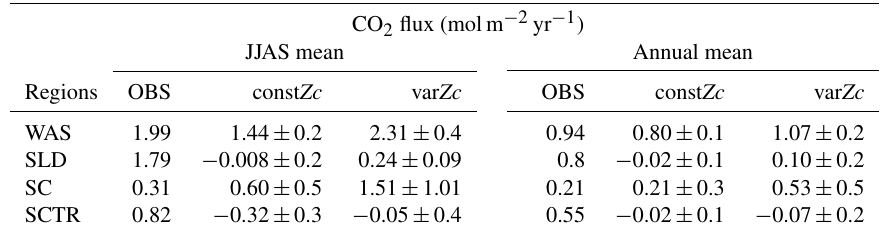
Figure 8. Annual mean bias of model phosphate when compared with climatological observational data (a) for const Zc and (b) for var Zc simulations. Corresponding annual mean biological source–sink profiles (c, d) in the model for WAS. Unit of phosphate is mmolm − 3 and biological source–sink is gCm − 3 yr − 1 . Table 1. WAS is western Arabian Sea, SLD is Sri Lanka Dome, SC is Sumatra coast, SCTR is Seychelles–Chagos thermocline ridge. JJAS mean and the climatological annual mean of CO 2 fluxes are from Takahashi observations, const Zc and var Zc simulations. Units aremolm − 2 yr − 1